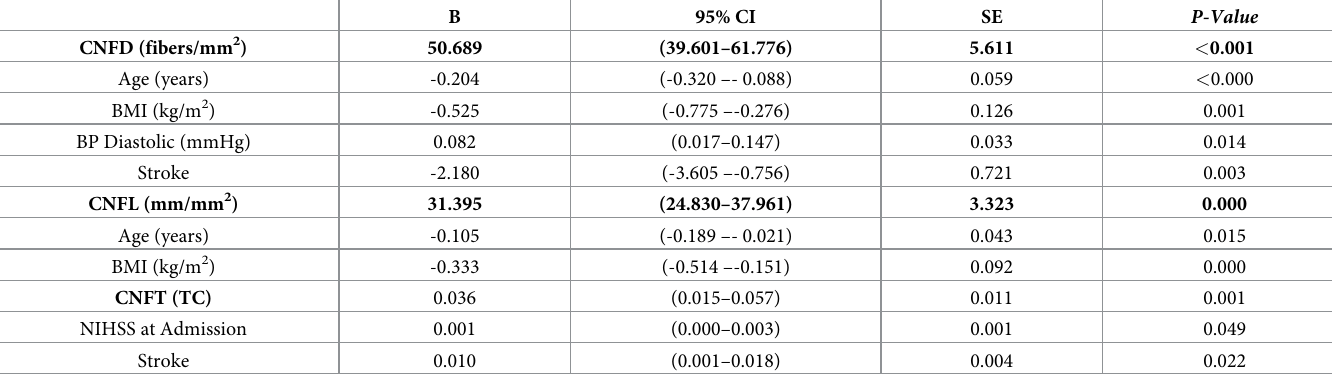
Table 3. Independent risk factors for altered corneal nerves in patients with acute ischemic